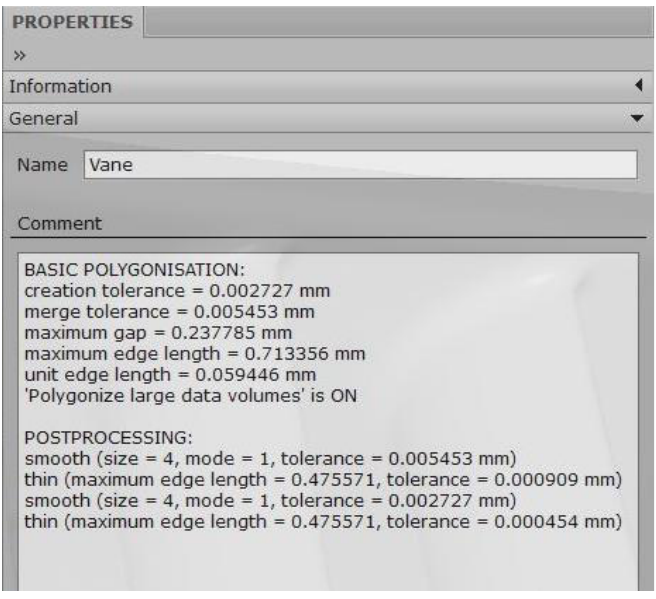
Figure 1. Atos Core—the idea of measurement. Figure 1. Atos Core — the idea of measurement.